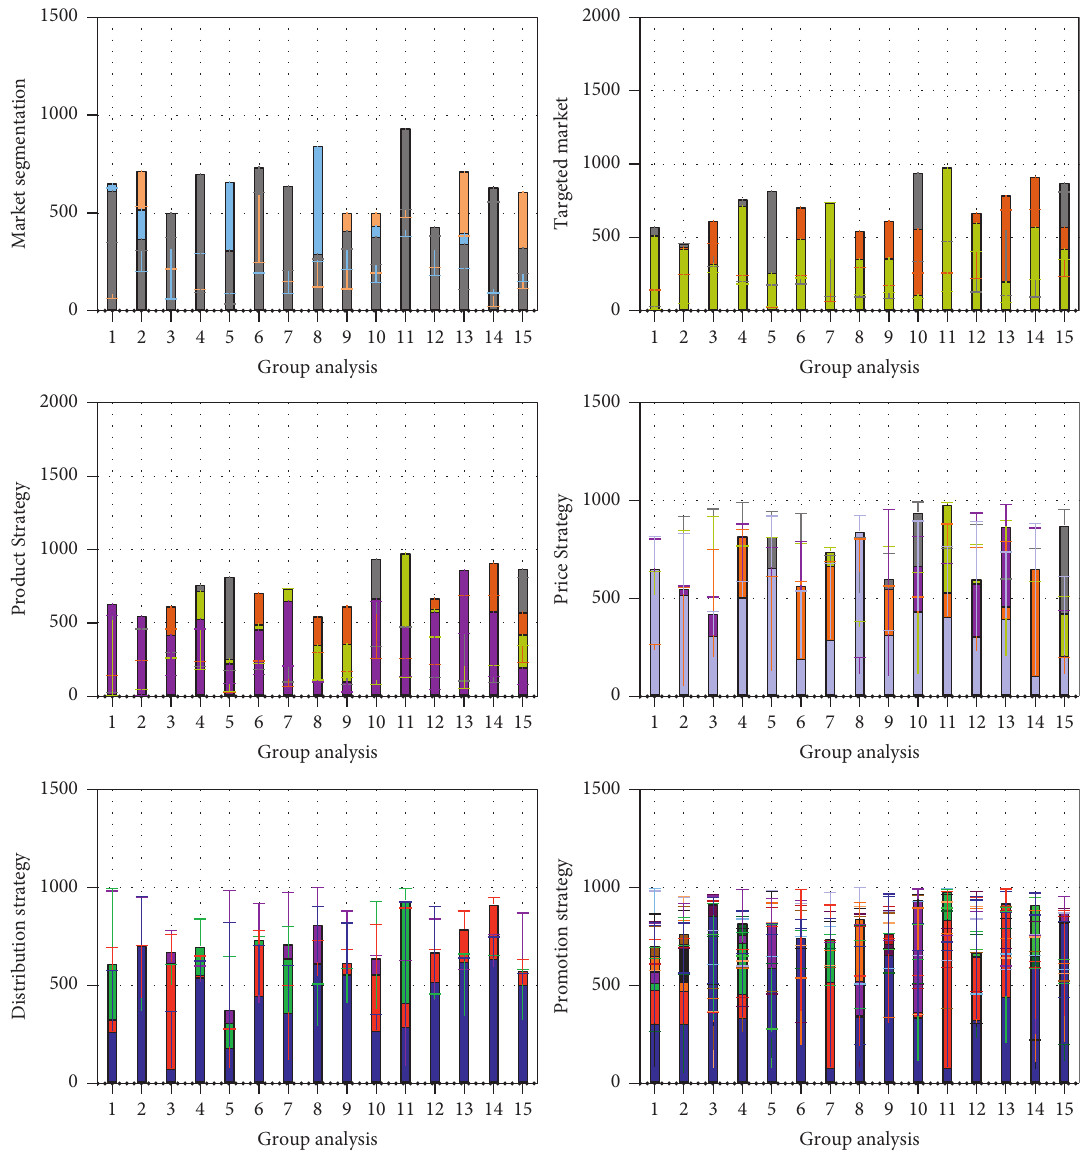
Figure 8: Service strategy classification effect under different market